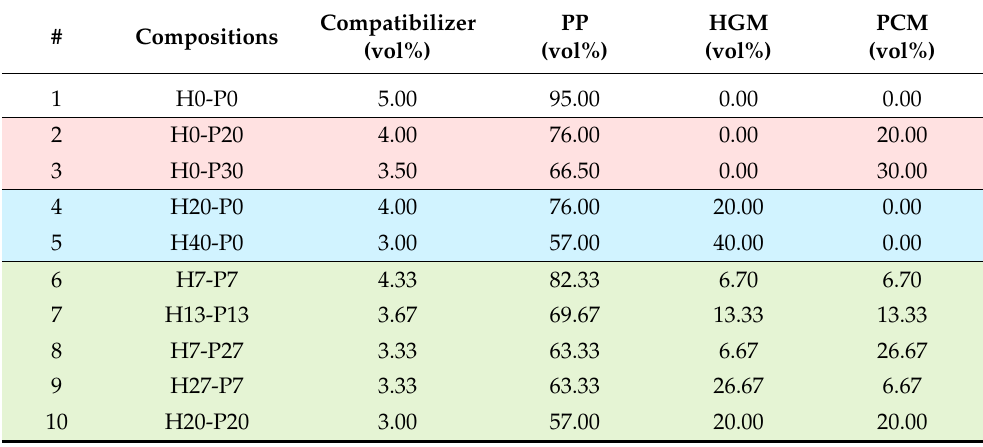
Figure 15. Representation of the selected compositions (highlighted by the red dots) on the ternary diagram. The numbers (1–10) on each dot correspond to the sample numbers indicated in Table 9. Table 9. List of the prepared samples with their nominal